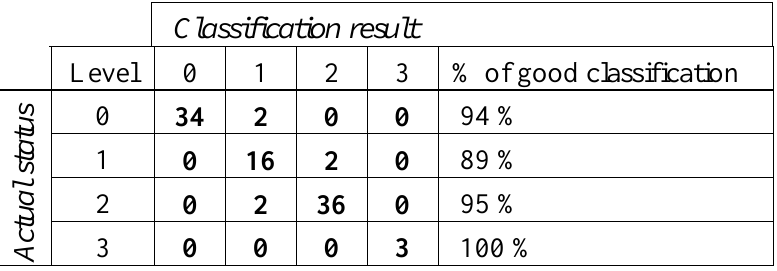
Table 2. Confusion matrix obtained for the classification of oil-palm trees in four levels of disease severity.